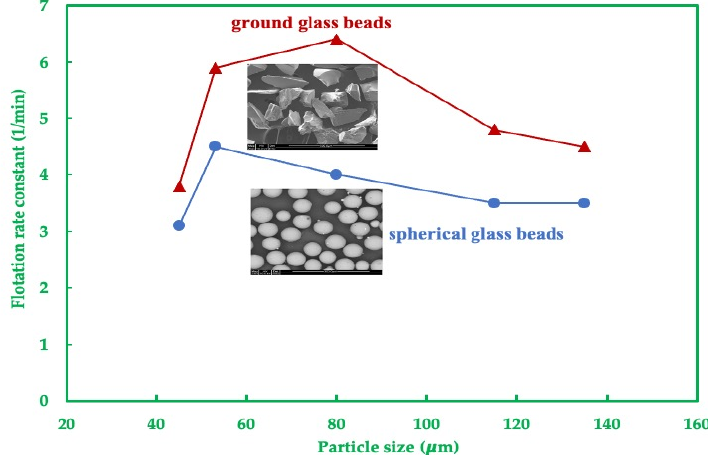
Figure 28. Effect of particle shape on flotation rate constants for ground and spherical glass beads at various sizes (modified from [383]) .